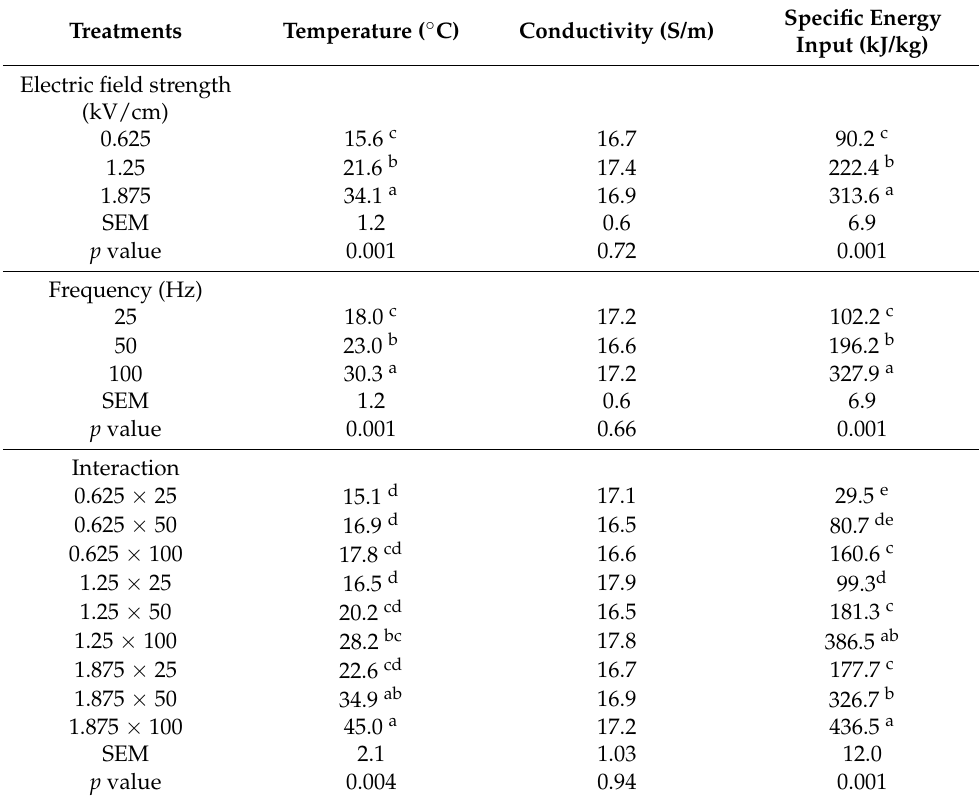
Table 2. PEF pre-treatment conditions and corresponding specific energy inputs. Treatments Temperature ( ◦